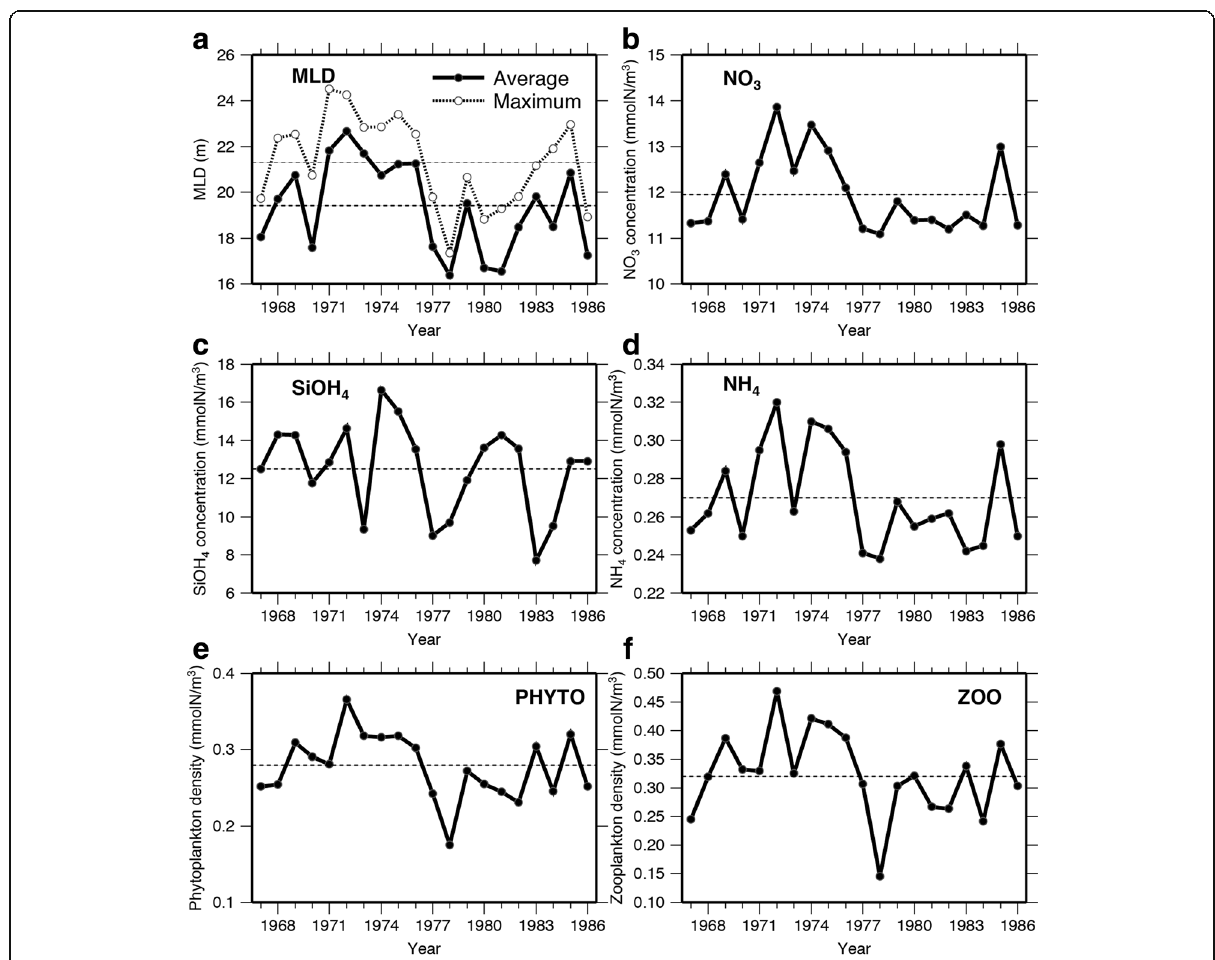
Fig. 12 Time series of selected physical and biological variables, a average and maximum mixed layer depth, b nitrate concentration, c silicate concentration, d ammonium concentration, e small plus large phytoplankton density, and f small plus large zooplankton density from the historical simulation. Values are averaged in the coastal region from January to April for a – f , and broken line represents the averaged value from 1967 to 1987. Nutrients and planktons are averaged in the upper 30m of the water column, the main habitat of the anchovy and sardine